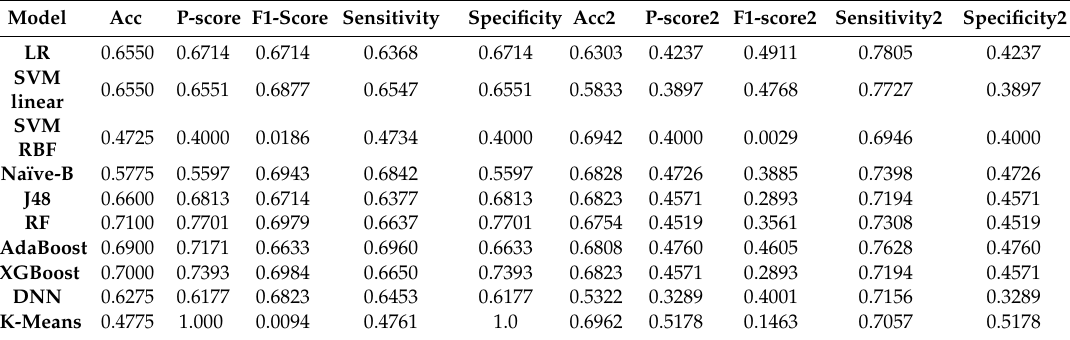
Table 2. Performance of di ff erent supervised, unsupervised and deep learning methods.